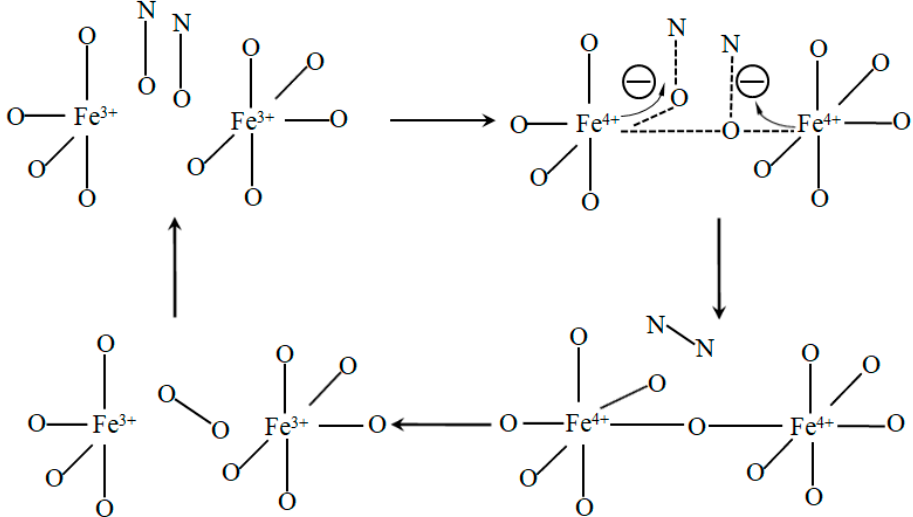
Figure 2. A possible mechanism of NO decomposition on the perovskite-type catalyst. Adapted with permission from [9], 2021, Elsevier .